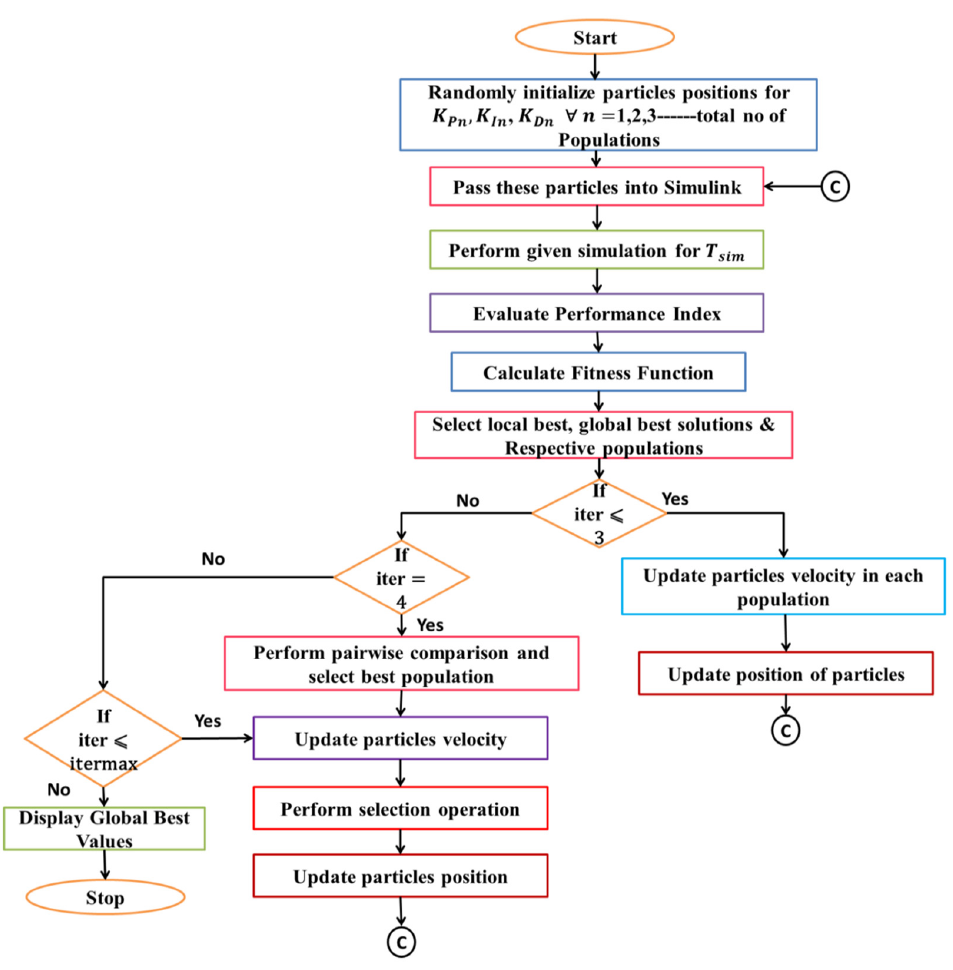
Figure 6. HAEFA flowchart.